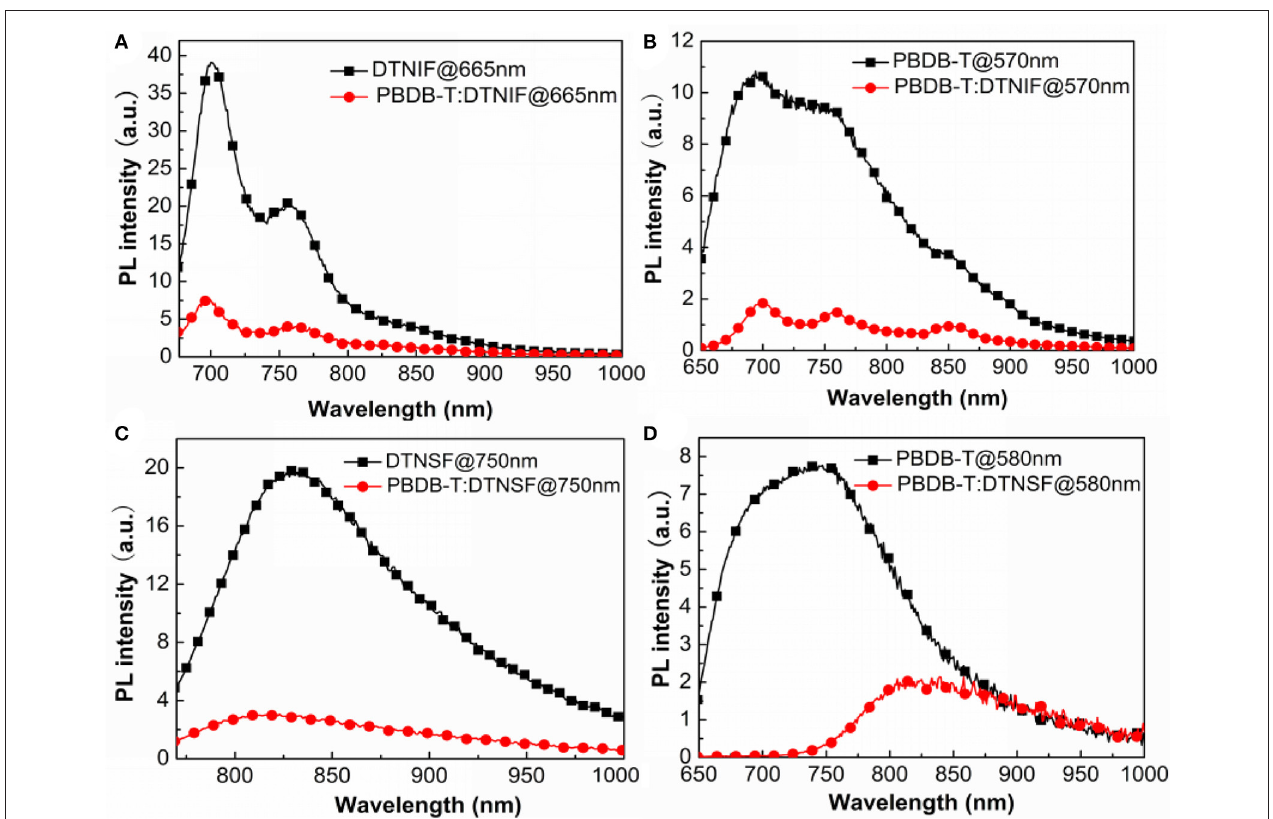
FIGURE 4 | Fluorescence quenching experiments of PBDB-T:DTNIF (A,B) and PBDB-T:DTNSF (C,D) excited mainly by the acceptor (A,C) and the donor (B,D) .